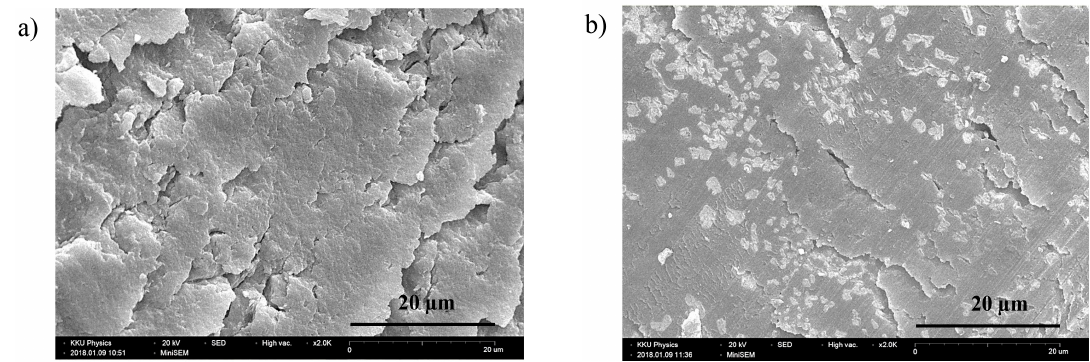
Figure 5. SEM images of ( a ) MMHs and ( b ) TC-MMHs.